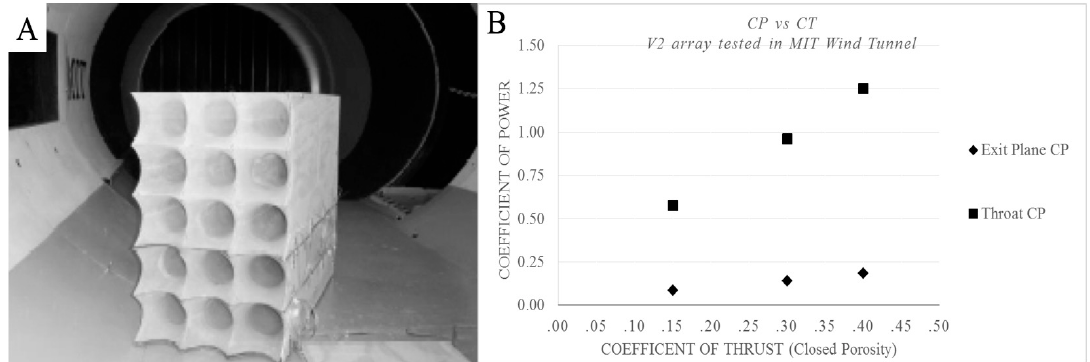
Figure A1. ( A ) Stagnation pressure measurements were taken for screens with open porosities